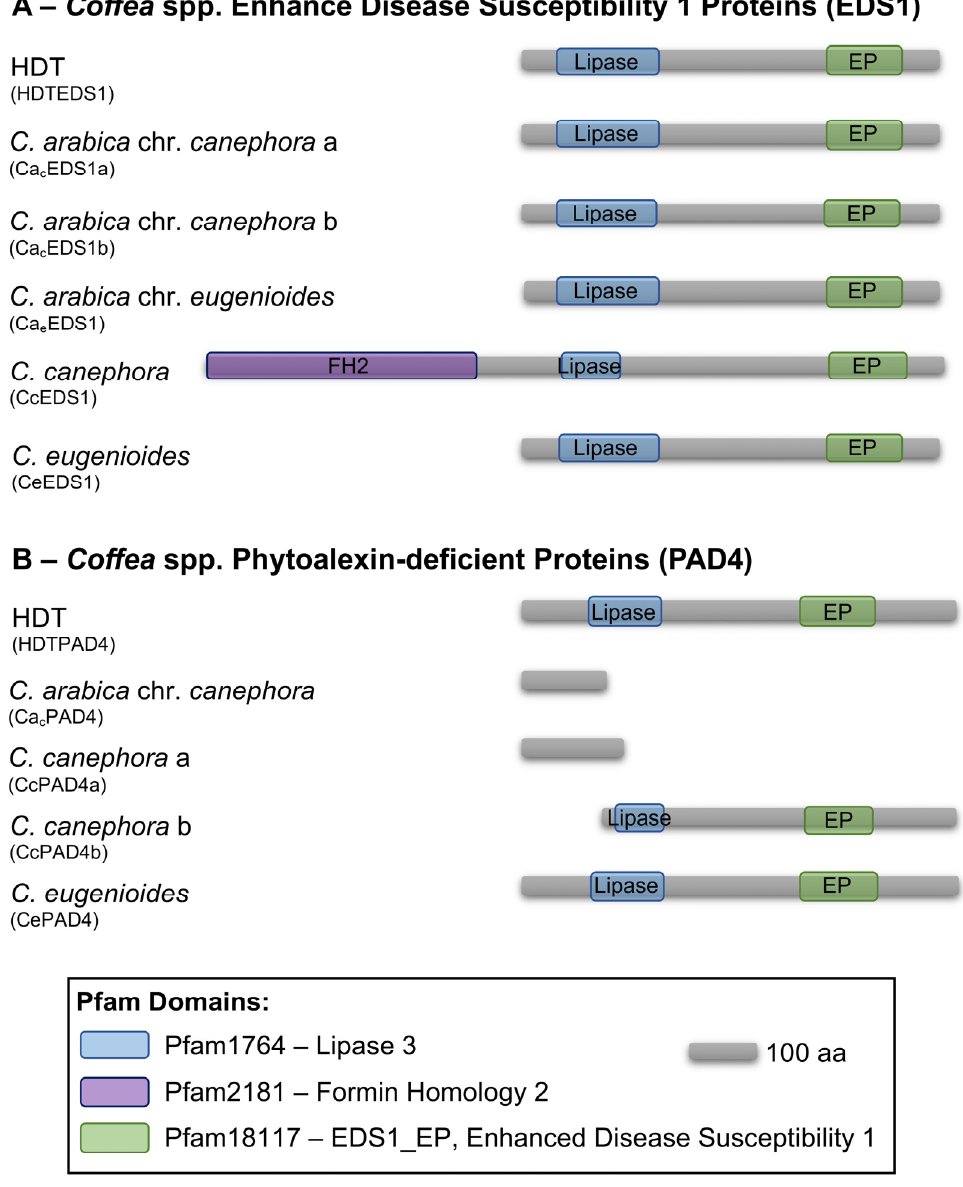
Figure 5. Schematic representation of the conserved domains of EDS1 ( A ) and PAD4 ( B ) proteins in Coffea spp. predicted proteins. The conserved motifs identified by screening the Pfam database (http://pfam.xfam.org) (accessed on 2 November 2022) were: Pfam02181, Formin Homology 2; Pfam01764, Lipase 3; Pfam018117, EDS1_EP, Enhanced Disease Susceptibility 1 EP Domain. Protein are represented in gray boxes, and conserved domains in colorful boxes.